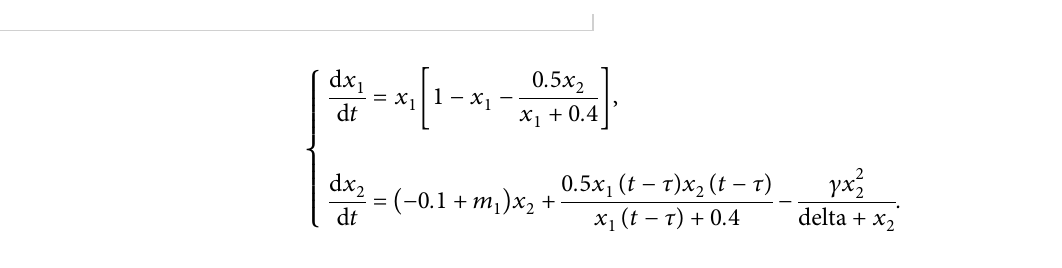
� 0 . 2, δ � 0 . 2, and c ∈ ( 0 . 2 , 0 . 5 ) 1